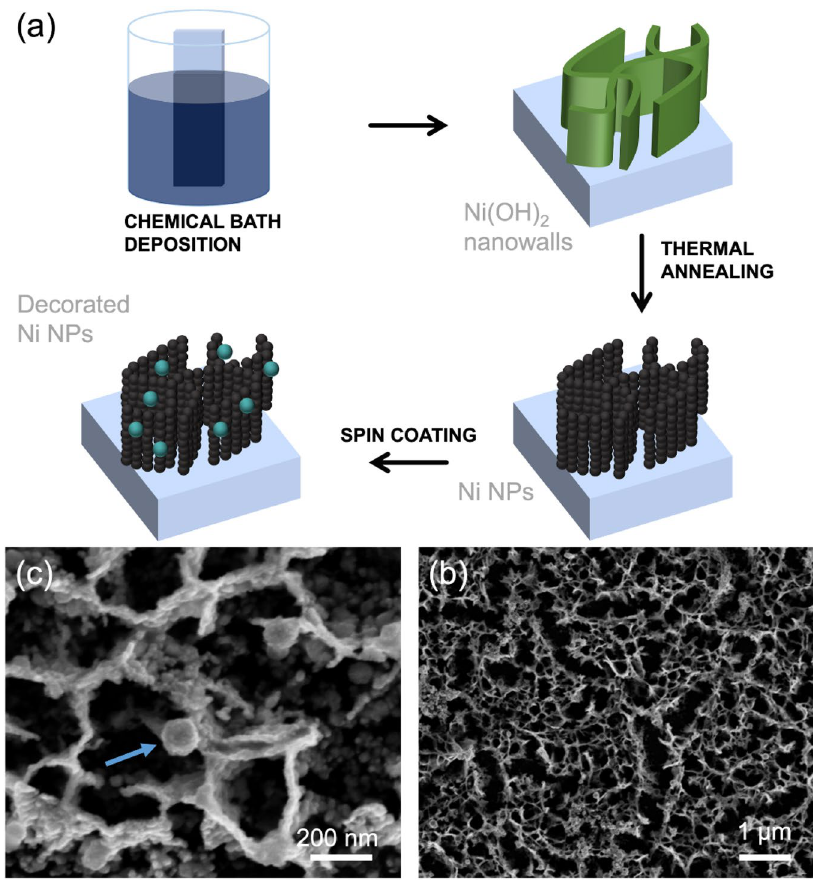
Figure 2. ( a ) Schematic representation of synthesis and decoration of Ni NPs; ( b ) SEM image of porous Ni NPs; ( c ) high magnification SEM image of Au@Pd NPs anchored on the top of Ni NPs (blue